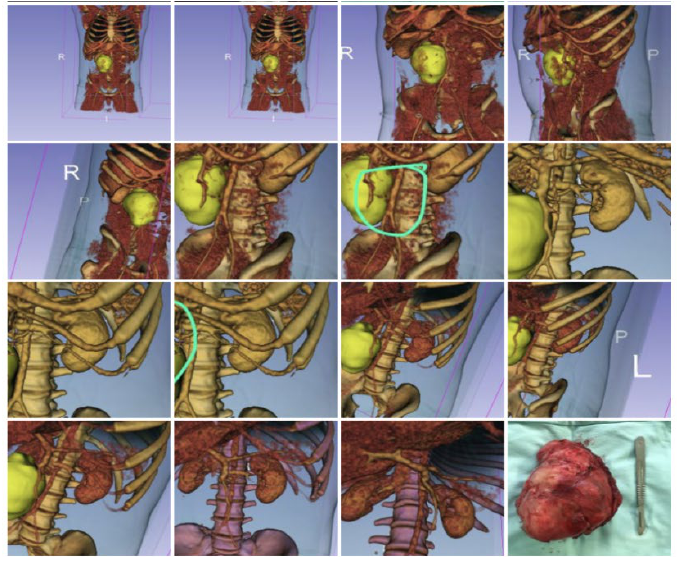
Figure 3. Para and retro-caval Post-chemotherapy Germ Cell Tumor. The mass displaced the cava without infiltration according CT-rendering and 3D reconstruction. It was excised completely without need for vascular surgery. R means right side; L= left side and P = posterior vision; the green circle show the tumor .